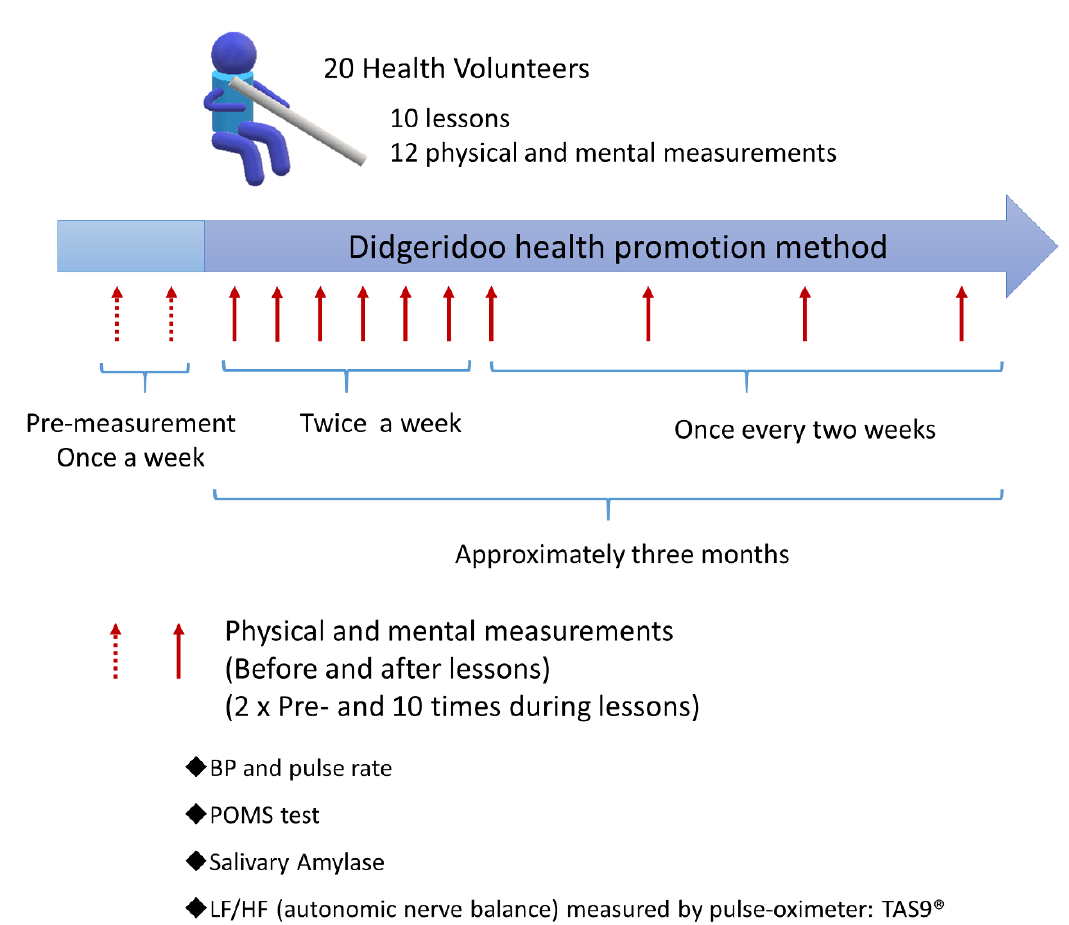
Figure 4. Lesson schedule and measurement of biological responses of subjects. Subjects who attended this study undertook 10 lessons of the DHPM, with the initial (intense) period of the course comprising two lessons a week (3 weeks, 6 lessons) and the final (more relaxed) period comprising lessons once every two weeks (8 weeks, 4 lessons). As a control, measurements of biological responses were performed twice prior to commencement of the entire course. The items measured as biological responses included mood surveys (using the Japanese version, Profile of Mood States 2nd Edition (POMS 2) (Kaneko Shobo Co., Ltd., Tokyo, Japan), blood pressure, and salivary amylase monitoring (Nipro Corporation, Osaka, Japan). The sAmy levels were measured using the salivary amylase monitor ® (Nipro dry clinical chemistry analyzer saliva amylase monitor ® , Product Code 59-014). The autonomic nervous balance was measured using a TAS9VIEW ® pulse oximeter (YKC, Tokyo, Japan).